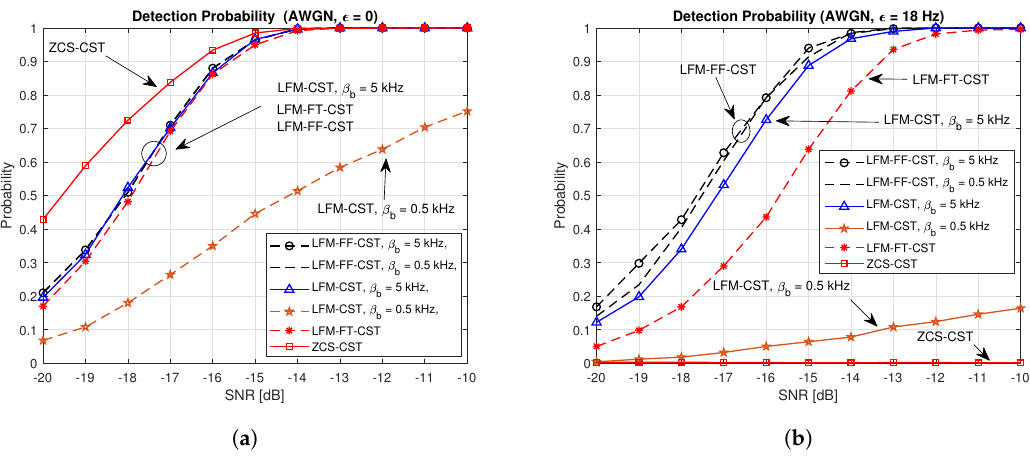
Figure 9. Detection probabilities of proposed and conventional techniques in AWGN channel. ( a ) AWGN, (cid:101) = 0 Hz; ( b ) AWGN, (cid:101) = 18 Hz.